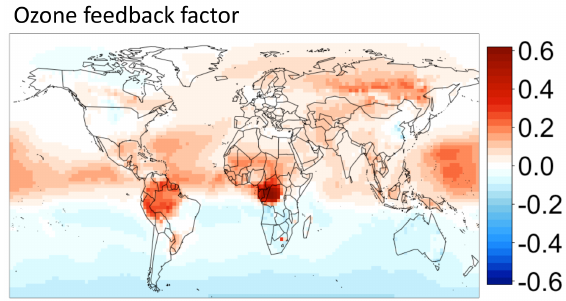
Figure 9. Ozone feedback factor ( f ) arising from the coupling be- tween surface ozone (JJA mean) and leaf area index (LAI). A value of 0 < f < 1 indicates a positive feedback (self-amplification of surface ozone), and a value of f < 0 indicates a negative feedback (self-dampening of surface